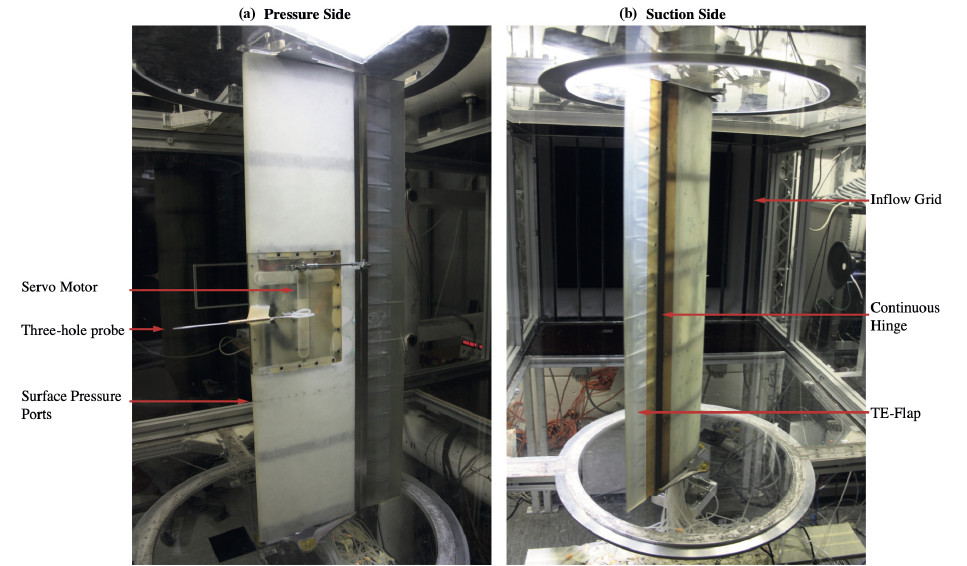
Figure 3. Mounted wing inside the wind tunnel. (a) Pressure side. (b) Suction side; view from downstream to